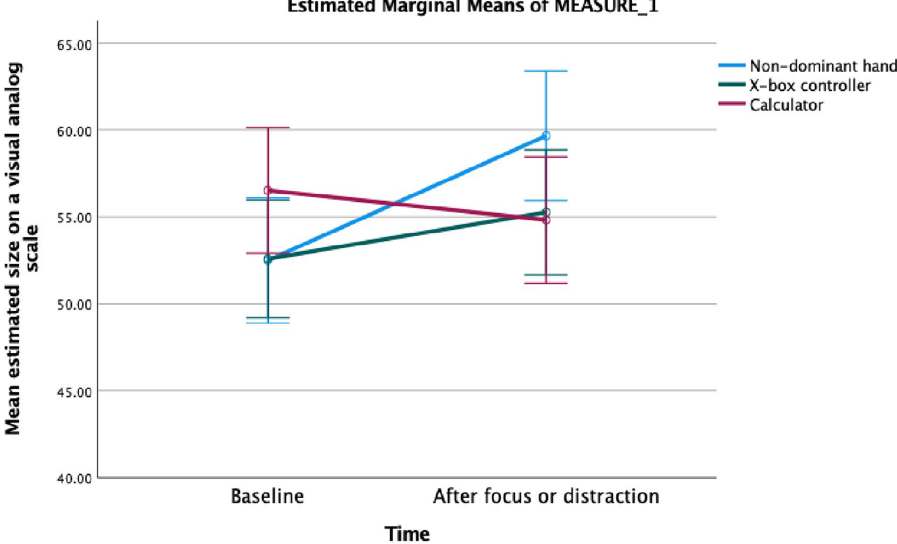
Figure 2. Graphic illustration of the mean estimated size of the non-dominant hand, the X-box controller and the calculator at baseline and after focus on the details or a distraction task. The error bars represent 95% confidence interval around the